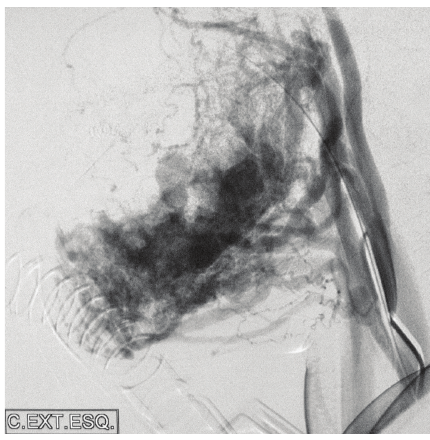
Figure 3: Preoperative angiography: left common carotid angiogram, lateral projection, and arterial phase showing extensive mandibular AVM with arterial supply from multiple sources and drainage into the dilated inferior alveolar